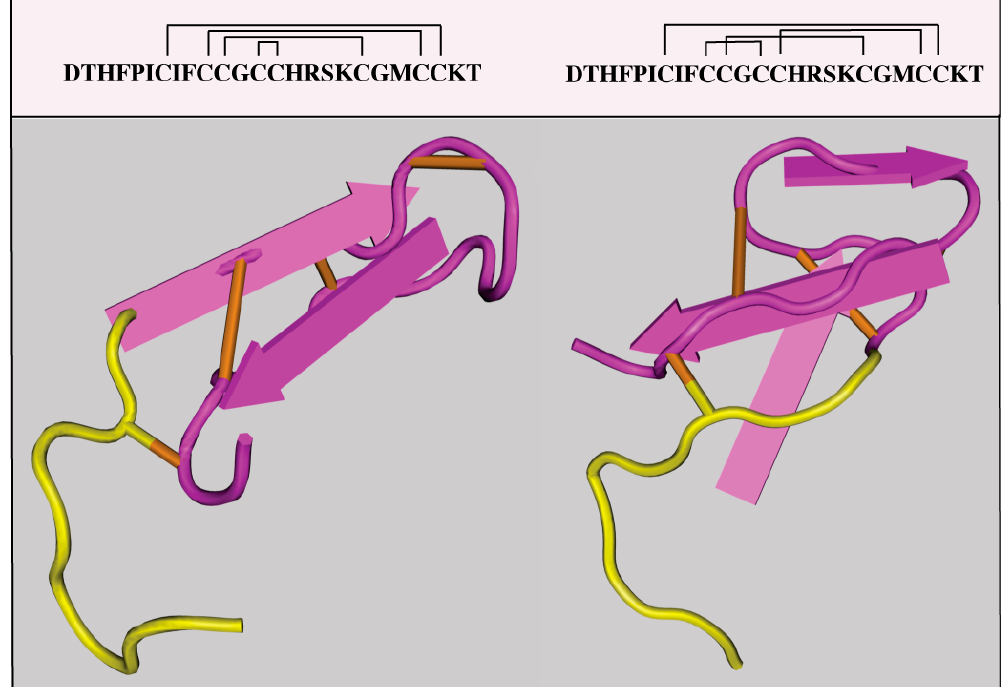
Figure 2. Proposed crystal structures of hepcidin. A structure with disulfide bonds between C7-C23, C10-C22, C13-C14 and C11-C19 (PDB ID: 1M4F) is shown on the left. An alternative structure with disulfide bonds between C7-C23, C10-C13, C11-C19 and C14-C22 (PDB ID: 2KEF) is shown on the right. The N-terminal amino acids which are essential for binding to ferroportin are highlighted in yellow.